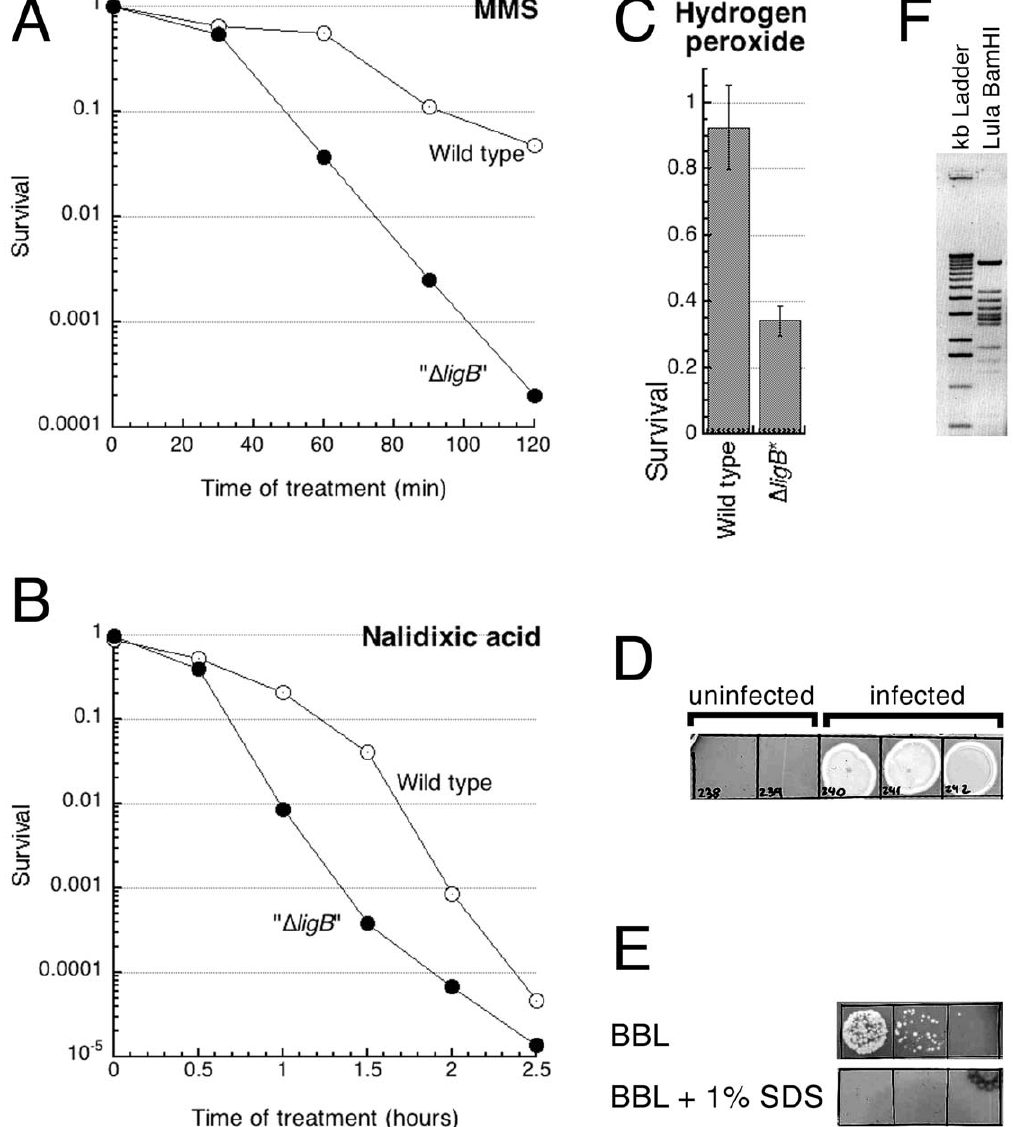
Figure 1. The DNA-damage sensitivity of the ‘‘ D ligB ’’ mutants and the assay for Lula presence. A. MMS treatment. Strains: wild type, GR523; ‘‘ D ligB ’’, LAP1. B. Nalidixic acid treatment. Strains as in ‘‘A’’. C. Hydrogen peroxide treatment. Strains as in ‘‘A’’. D. Assay for the presence of Lula. Supernatants of saturated cultures were spotted by 10 m l onto a lawn of uninfected cells (AB1157), and the plates were incubated at 30 u C for 20 hours. E. SDS-sensitivity of Lula. 10 m l of the first, second and third dilution of a supernatant of saturated lysogen culture were spotted on a lawn of uninfected cells (AB1157). F. An inverted image of ethidium bromide-stained gel showing Lula virion DNA digested with BamHI.